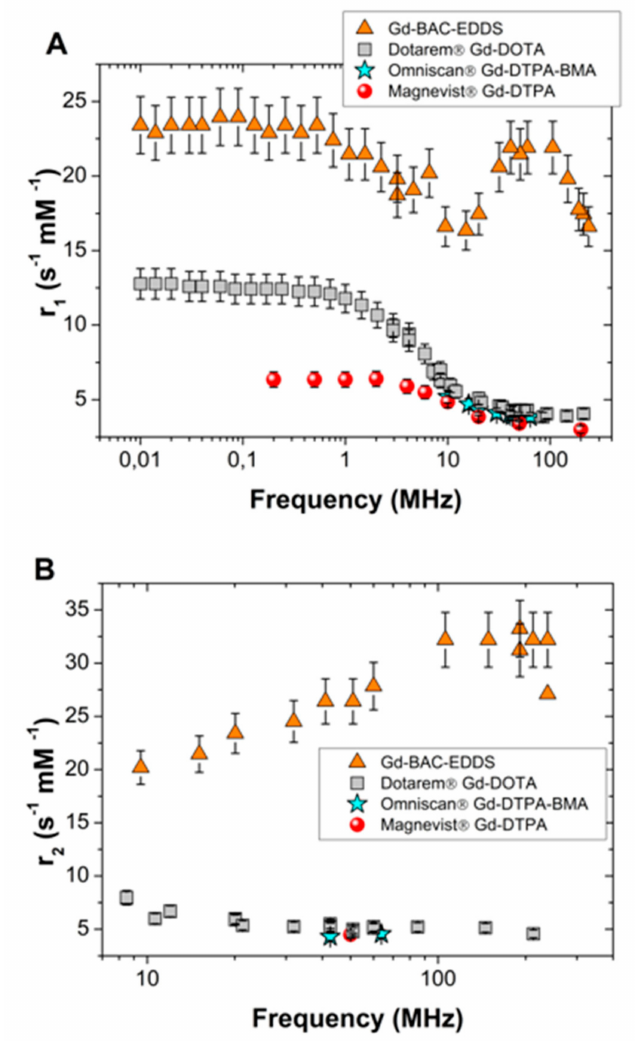
Figure 7. ( A ) Longitudinal ( r 1 ) relaxivity (NMRD profile) at room temperature in the frequency range 0.01 < ν < 240 MHz measured for Gd-BAC-EDDS polymer complex compared to r 1 of three Gd chelate commercial contrast agents measured in similar frequency ranges. ( B ) Transverse ( r 2 ) relaxivity (NMRD profile) at room temperature in the frequency range 10 < ν < 240 MHz measured for Gd-BAC-EDDS polymer complex compared to r 1 of three Gd chelate commercial contrast